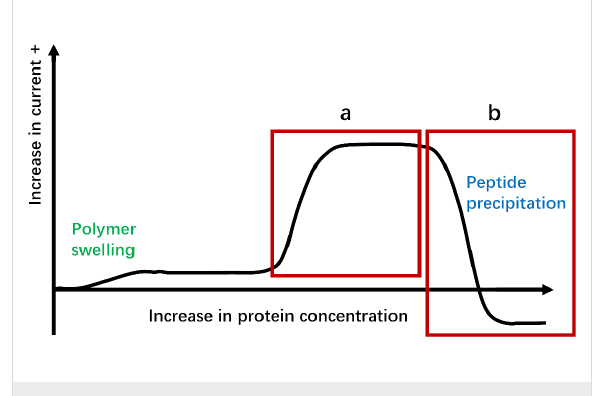
Figure 6: Potential for an immediate, rapid change in current. a) The binding event being monitored has already started. b) Precipitation of the protein